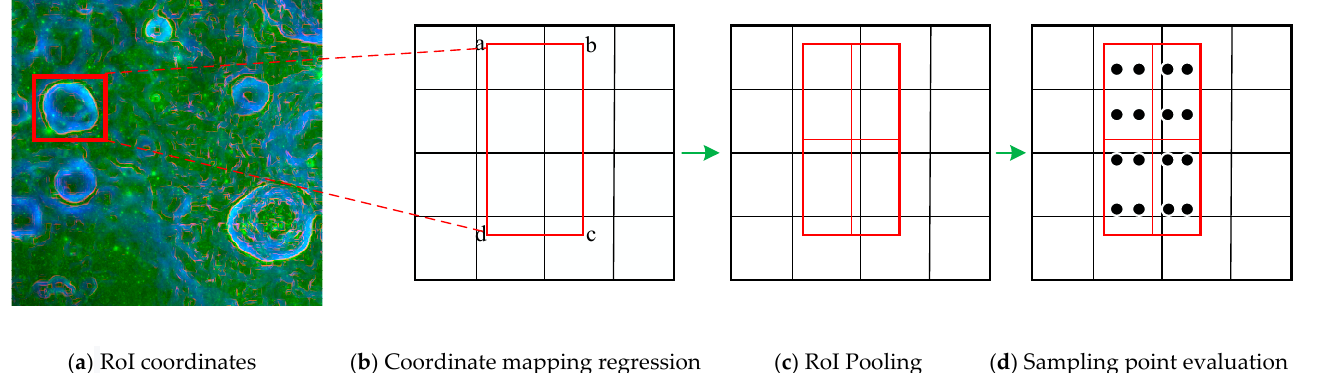
Figure 6. The improved RoI Pooling using bilinear interpolation.